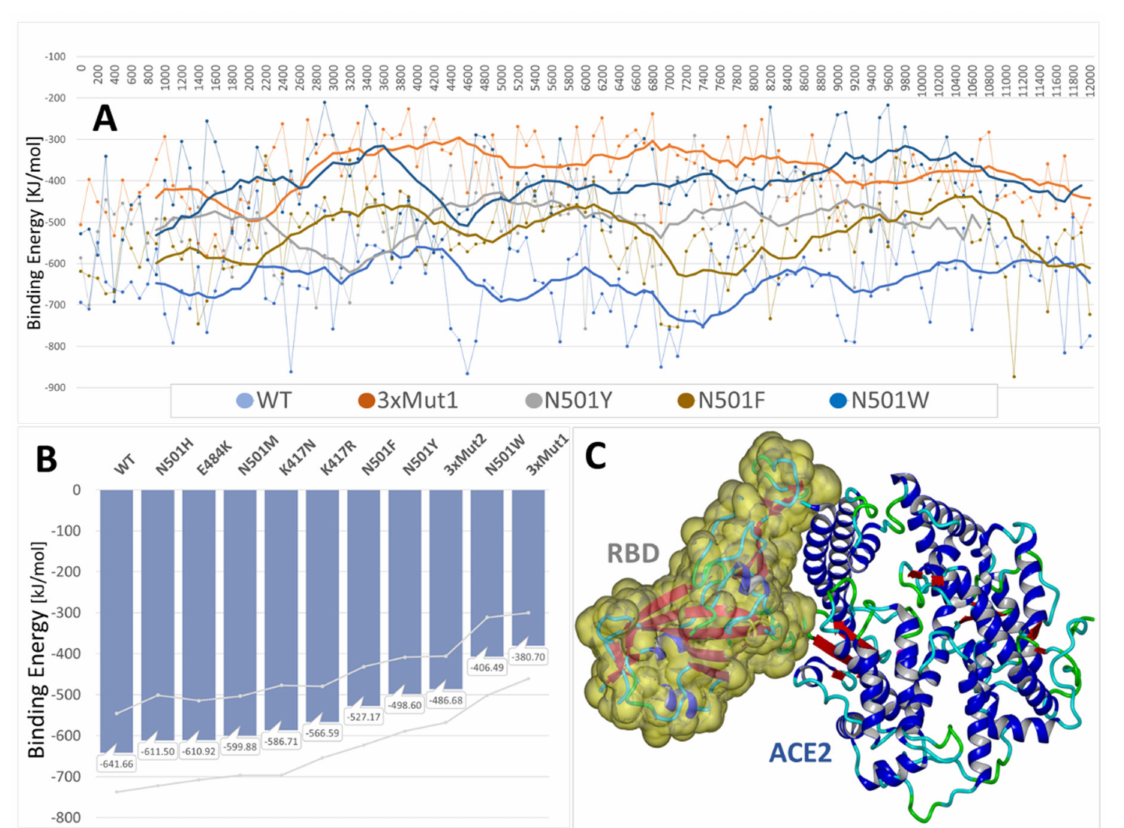
Figure 6. ( A ) Comparison of RBD-ACE2 binding energy MD trajectories for five RBD variants. For reasons of visual clarity, only five of the nine MD simulation trajectories are plotted. These in- cluded the wild-type strain (WT), the triple mutant “3xMut1” (see below), N501Y, N501F, and N501W. Heavy solid lines are 10-point rolling averages. Thinner lines are binding energy data calculated at 100-ps intervals. The wild-type PDB 6LZG complex and variants thereof were used to perform 12–18 ns of MD simulation in physiological saline at 311 O K (NPT ensemble, AMBER-14; initial 12 ns are plotted). Simulations included the following RBD variants: (1) wild-type 6LZG, (2) N501H, (3) E484K, (4) N501M, (5) K417N, (6) K417R, (7) N501Y, (8) triple mutant “3xMut2” harboring N501Y, K417R, and E484K, and (9) triple mutant “3xMut1” harboring N501Y, K417N, and E484K. ( B ) Average binding energies (vertical bars) and standard deviations (gray lines) over the nine MD trajectories ( n = 120–180). ( C ) RBD-ACE2 complex of 6LZG at t = 0 ns. The RBD fragment is depicted as the Van der Waals surface. Water and NaCl ions have been hidden for